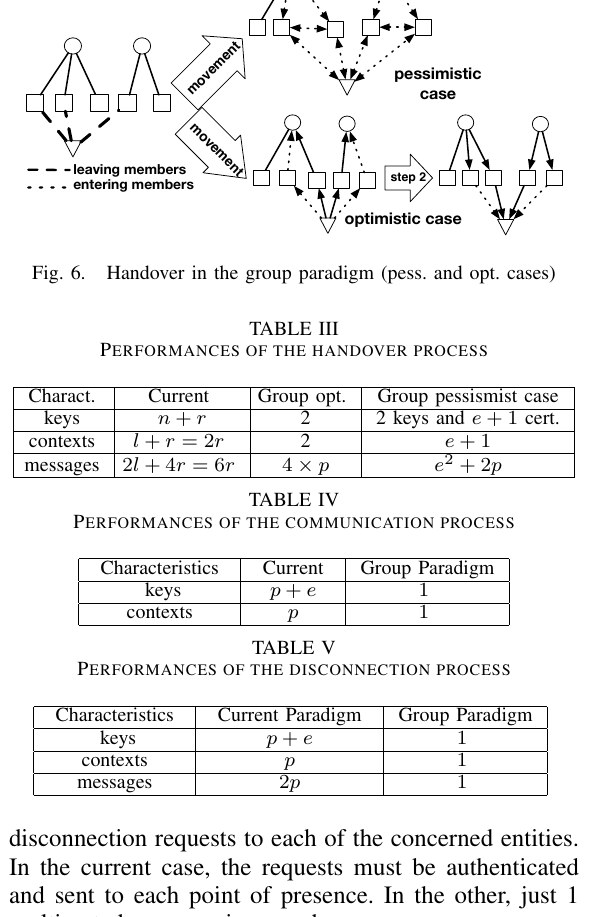
Fig. 5. Handover in the current paradigm